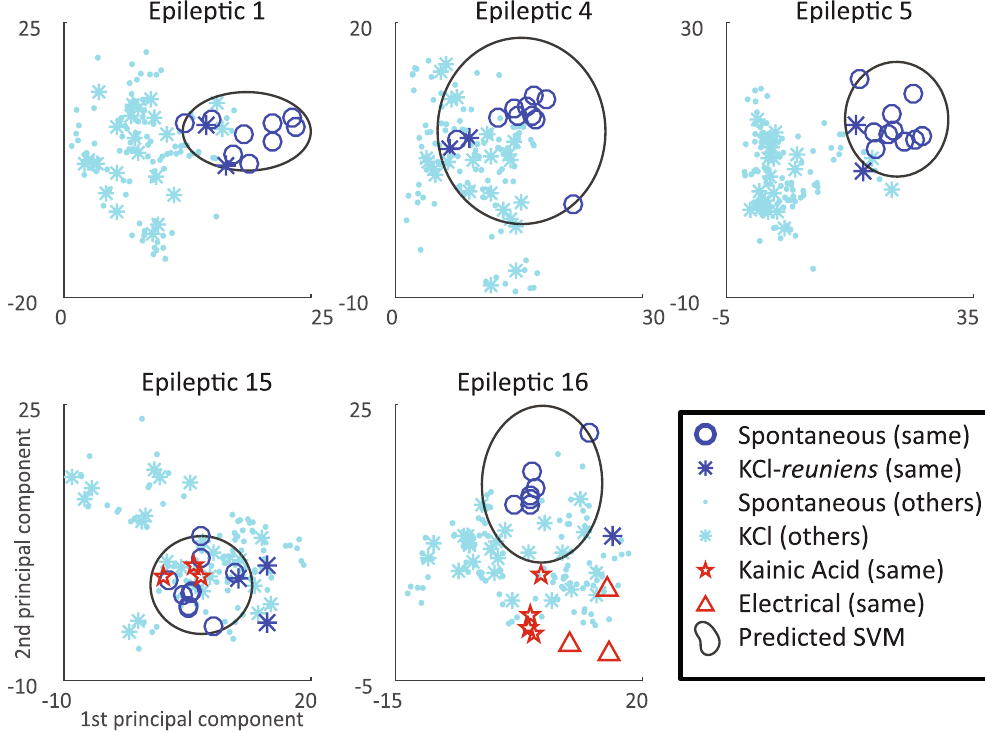
Figure 4. Comparison of feature distributions. A set of 44 features was calculated for each seizure, then reduced to two dimensions with principal components analysis. Plots show the location of each seizure’s first two components. The set of spontaneous seizures in a given animal was used to determine the one-class SVM (black line). Each seizure was then compared with this threshold to determine if it belonged within the spontaneous seizures’ classification. We compared all seizures from the same animal (dark blue) and other animals (light blue). Seizures occurring during the KCl- reuniens injections (dark blue * ) were indistinguishable from spontaneous seizures of the same animal (Dark blue circle) in most animals (top row). A small number of seizures occurring during the KCl injections were distinct from their spontaneous groups (bottom row). Most kainic acid-induced seizures (red stars) and all electrical-induced seizures (red triangles) were distinct from spontaneous seizures, as were the majority of induced and spontaneous seizures from other animals (light blue * and circles).